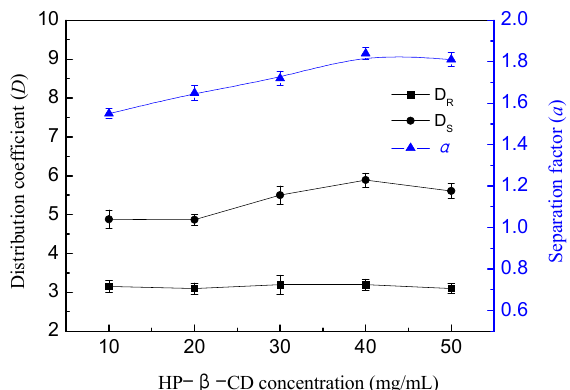
Figure 5. Effect of HP- β -CD concentration on the chiral extraction of phenylalanine enantiomers. The extraction conditions were as follows: 30 wt% [Ch][L-Pro], 7.8wt% K 3 PO 4 , 15 mg/mL phenylalanine. The extraction experiments were done at room temperature and without adjusting the system pH.